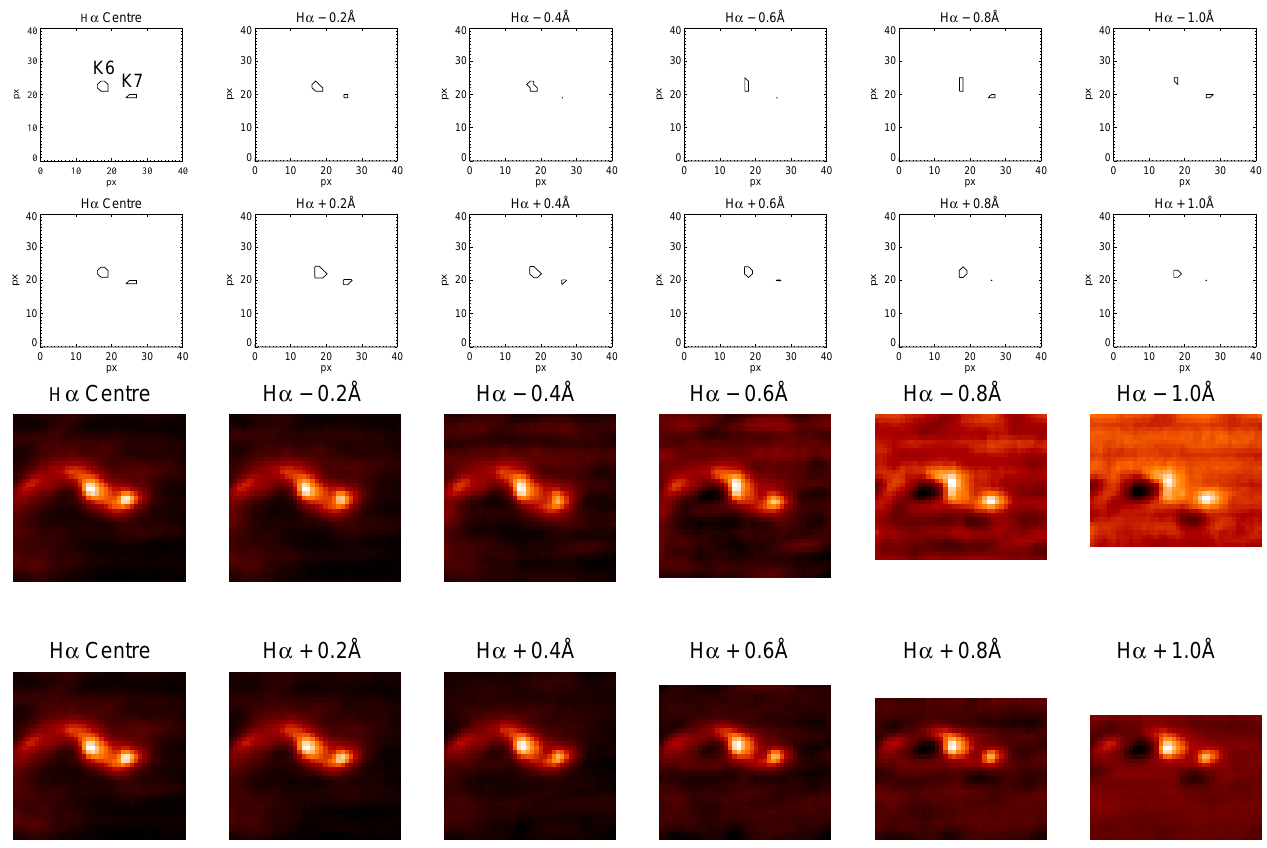
Fig. 5. C8.3 class solar flare (kernels K6 and K7) in NOAA 10786 active region observed at 08:01:22UT on 12 July 2005. The upper and lower panels are the same as on Fig. 1.